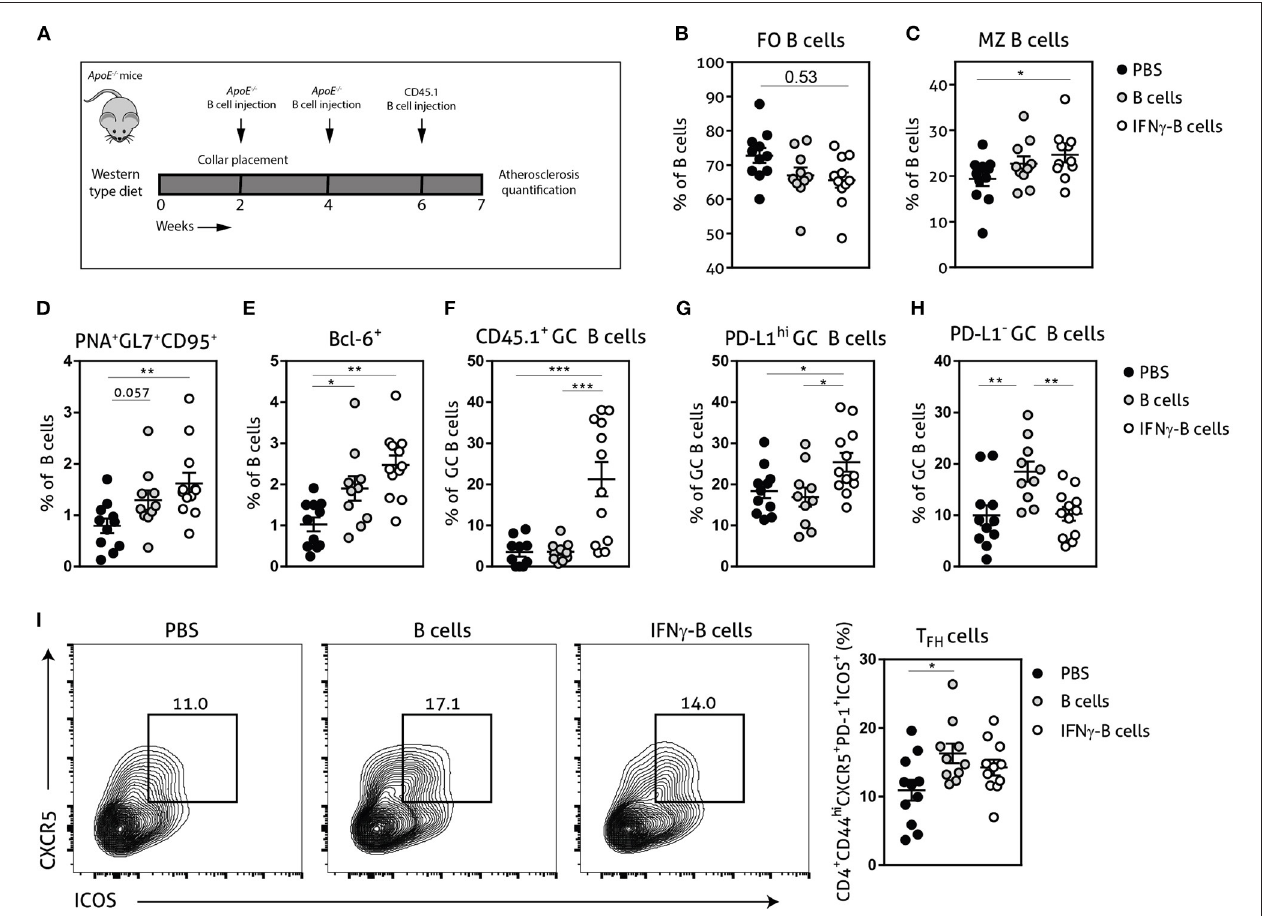
FIGURE 3 | Adoptive transfer of IFN γ -B cells during atherosclerosis development affects the T FH –GC B cell axis. (A) ApoE − / − mice were fed a Western type diet for 7 weeks. After 2 weeks they received a perivascular collar and were treated with PBS, freshly isolated B cells (B cells) or B cells stimulated with 20.0ng/ml IFN γ for 24h (IFN γ -B cells). Mice received a total of three injections and injections were spaced every two weeks. After 7 weeks, mice were sacrificed and spleens were analyzed with flow cytometry. Flow cytometry quantification of (B) follicular (FO) B cells, (C) marginal zone (MZ) B cells, (D) extracellular staining of germinal center B cells, (E) intracellular staining of germinal center B cells, (F) CD45.1 + germinal center B cells, (G) PD-L1 hi germinal center B cells, (H) PD-L1 − germinal center B cells and (I) flow charts and quantification of follicular helper T cells (CD44 hi PD-1 + CXCR5 + ICOS + ). Data are analyzed with a One-Way ANOVA and shown as mean ± SEM (* p < 0.05, ** p < 0.01, *** p < 0.001). n =